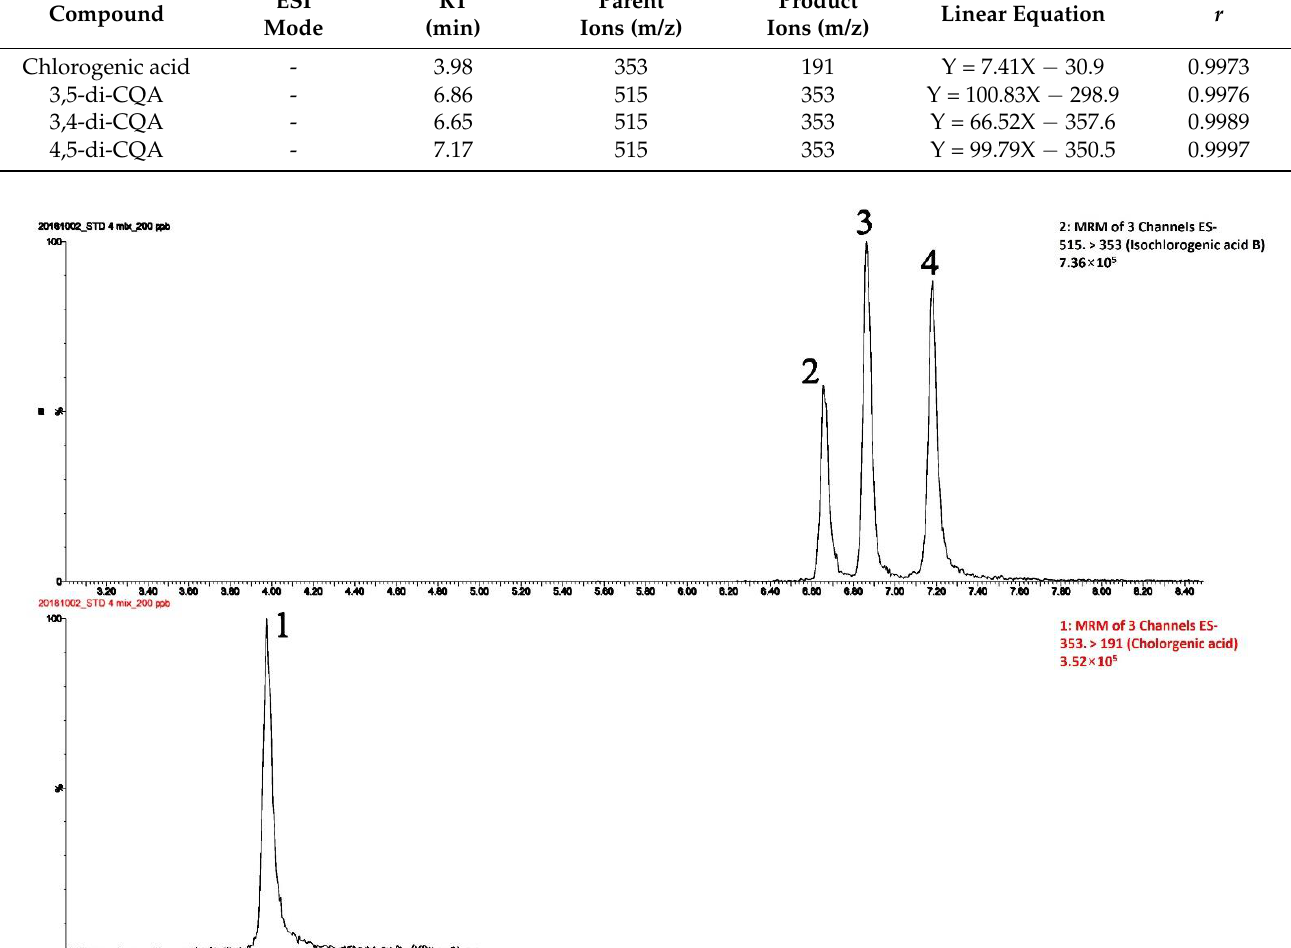
Figure 2. LC-MS/MS analysis of chlorogenic acid (CGA, peak 1) , 3,4-dicaffeoylquinic acid